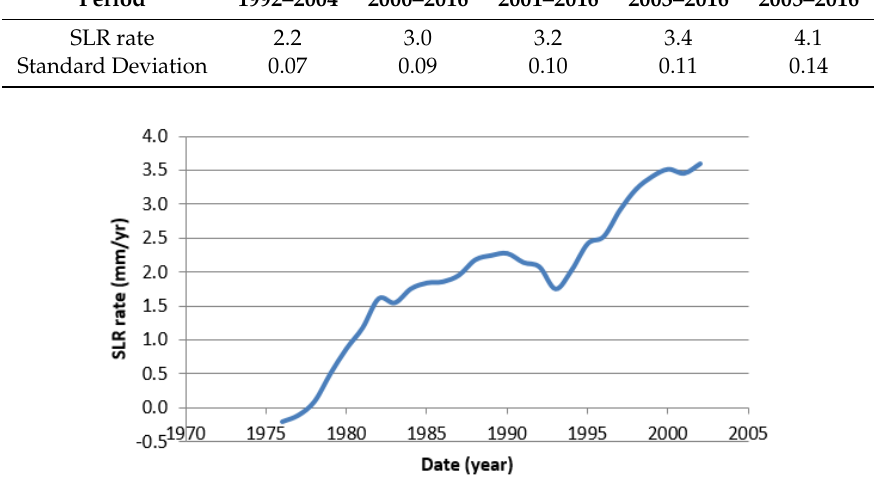
Figure 4. SLR rate of the 10-year moving average over the Cascais TG secular series (Figure 2).